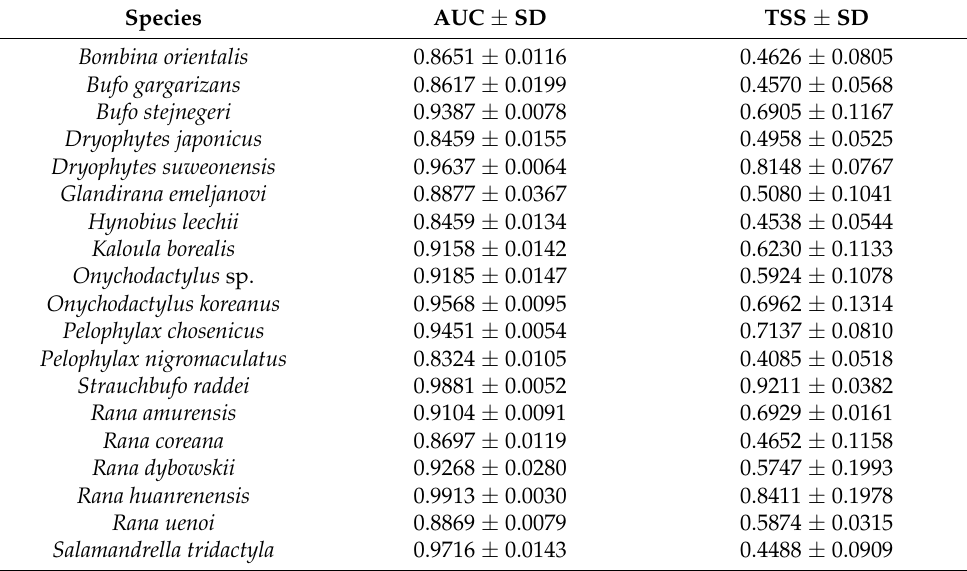
Table 3. AUC and TSS values of the 10-percentile training omission threshold generated by the MaxEnt models. The values were used to select the best fitting